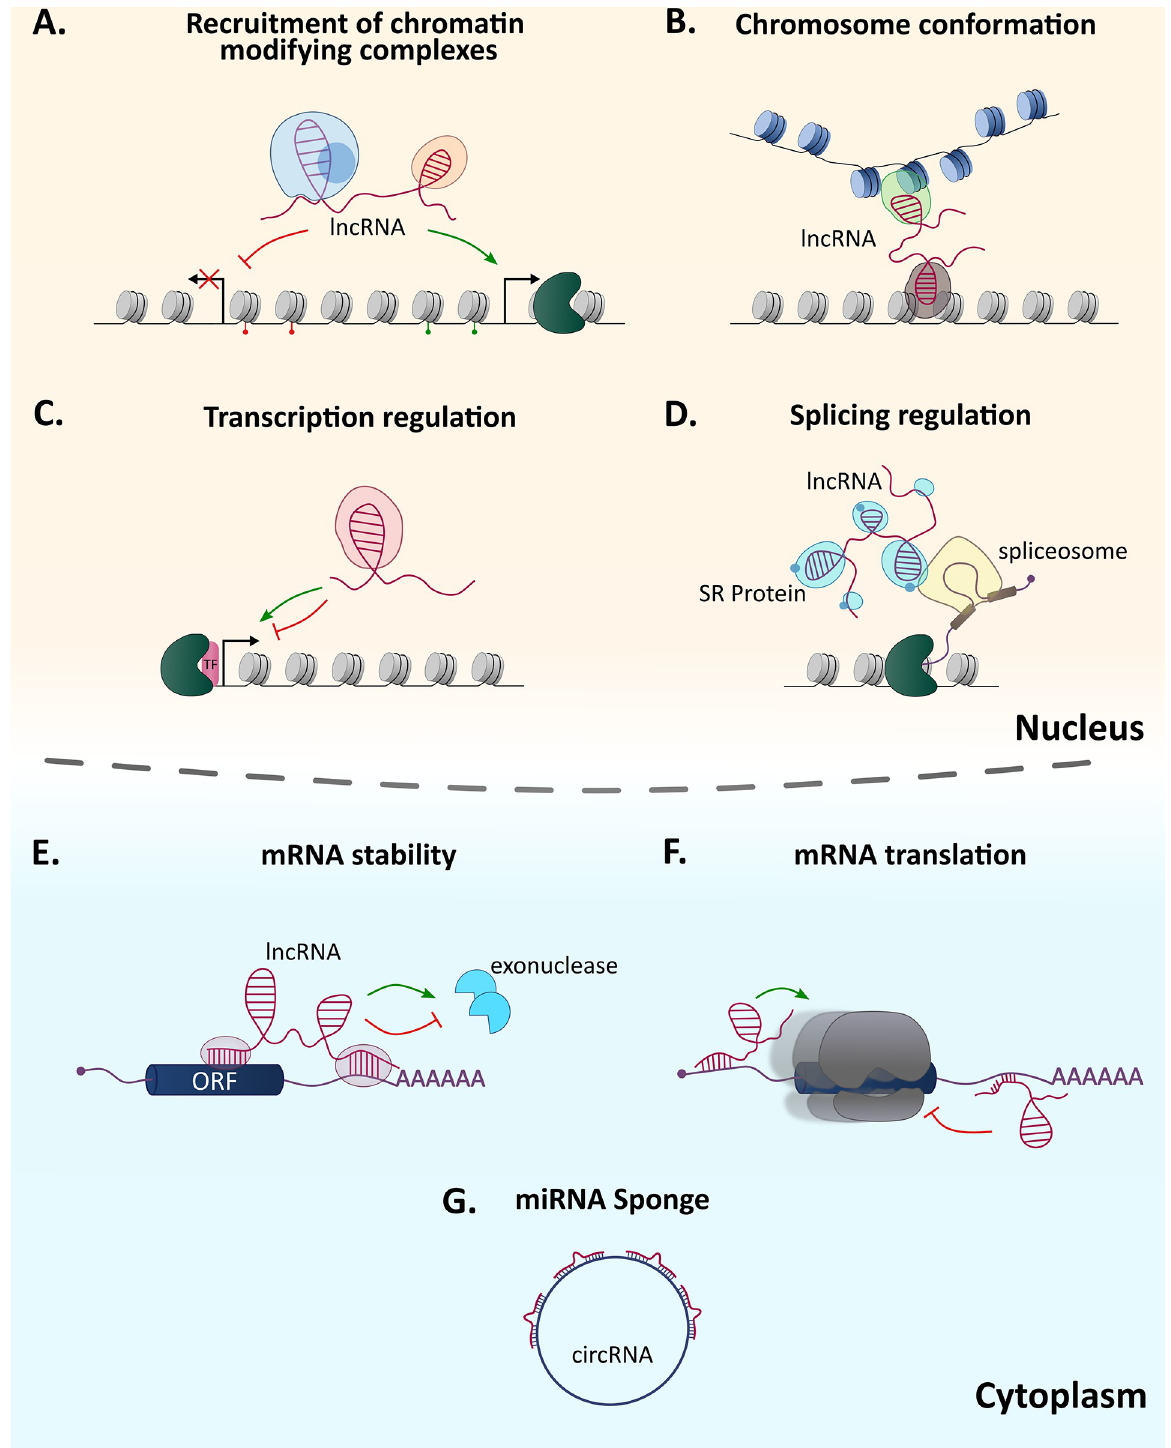
Fig 3. lncRNAs operate by different mechanisms. The subcellular localization of lncRNAs determines their mechanisms and biological functions. Inside the nucleus (upper) they can perform regulatory functions such as (A) scaffolds for recruitment of regulatory factors and protein complexes, (B) regulation of chromatin conformation/chromatin architecture, (C) transcription regulation of target genes, and (D) regulation of pre-mRNA splicing. Cytoplasmic lncRNAs (lower) are involved in the modulation of (E) mRNA stability and decay, (F) mRNA translation, and act as a (G) miRNA sponge to inhibit host (human)-encoded miRNAs. circRNA, circular RNA; lncRNA, long ncRNA; miRNA, microRNA.